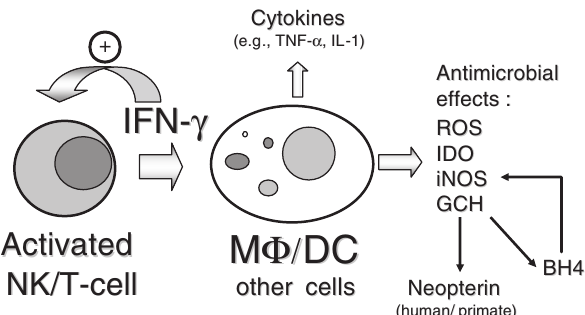
Figure 2 Within the cellular immune response ( = Th1-type immune response) T cells and natural killer (NK) cells release pro-inflam- matory cytokines like interferon- γ (IFN- γ ). IFN- γ , on the one